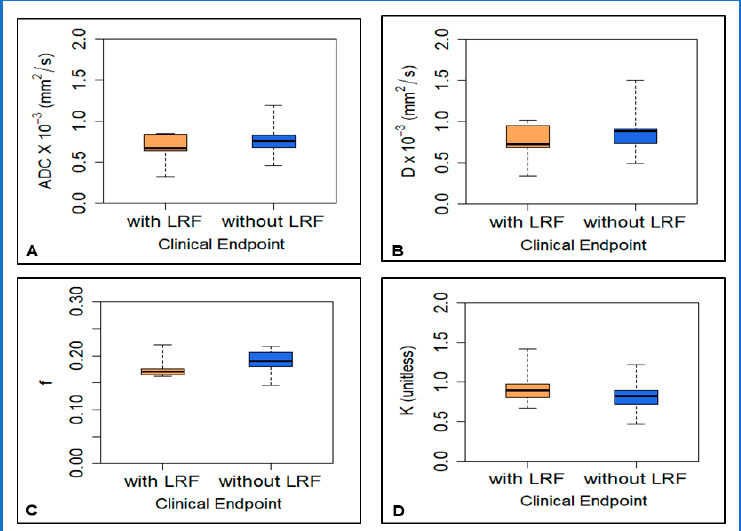
Figure 1. Box plot comparing the pre-treatment mean value of ( A ) apparent diffusion coefficient (ADC), ( B ) true diffusion coefficient (D), ( C ) perfusion fraction (f), and ( D ) kurtosis coefficient ( K ) between patients with and without locoregional failure in nasopharyngeal cancer. f showed a certain trend towards significance ( p = 0.08). Boxes represent interquartile range. Whiskers represent range of all values. Horizontal line within box is median